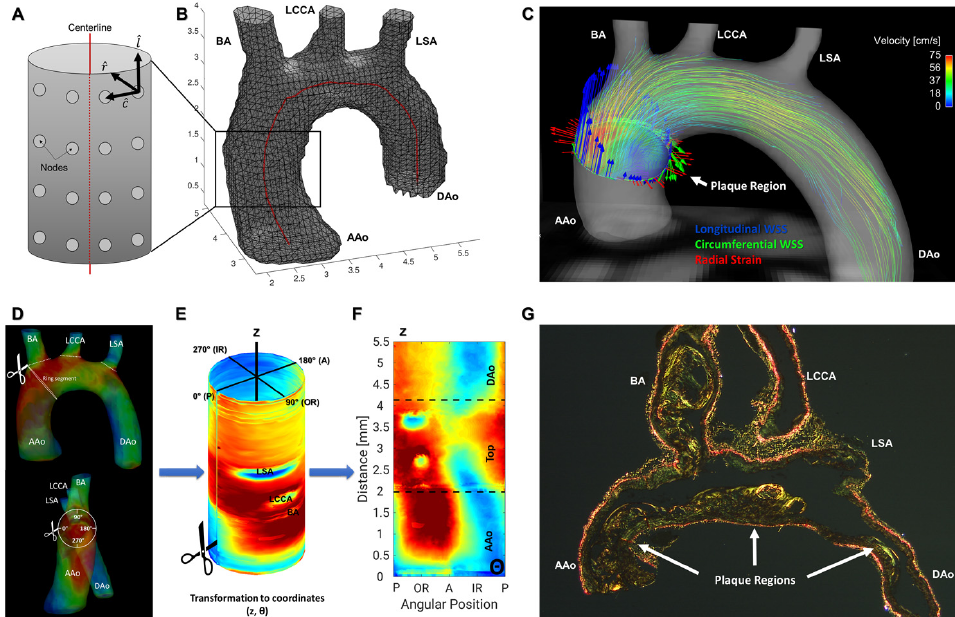
Figure 2. Lumen surface grid and 2D projection map generation. ( A ) Schematic zoom of an aortic segment from ( B ). For each node, WSS components (ˆ l —longitudinal; ˆ c —circumferential; ˆ r —radial) were determined. ( B ) Lumen surface grid of the aorta with centerline (red). ( C ) Aortic arch of an Apoe − / − mouse with streamlines and WSS components. Blue arrows: Longitudinal WSS. Green arrows: Circumferential WSS. Red arrows: Radial strain. ( D ) Anterior (top) and frontal (bottom) view of the aorta with mean WSS values and a schematic ring segment. ( E ) Branches are cut off, aorta was opened on the posterior side at 0 ◦ and the WSS was projected to the coordinates (z, θ ). Convention: θ = 0 ◦ : Posterior side (P). ( F ) 2D projection map of WSS values of the arch. WSS and OSI values of the exact plaque position in the inner radius were used for histological correlation ( G ). AAo: Ascending aorta; BA: brachiocephalic artery; LCCA: left common carotid artery; LSA: left subclavian artery; DAo: descending